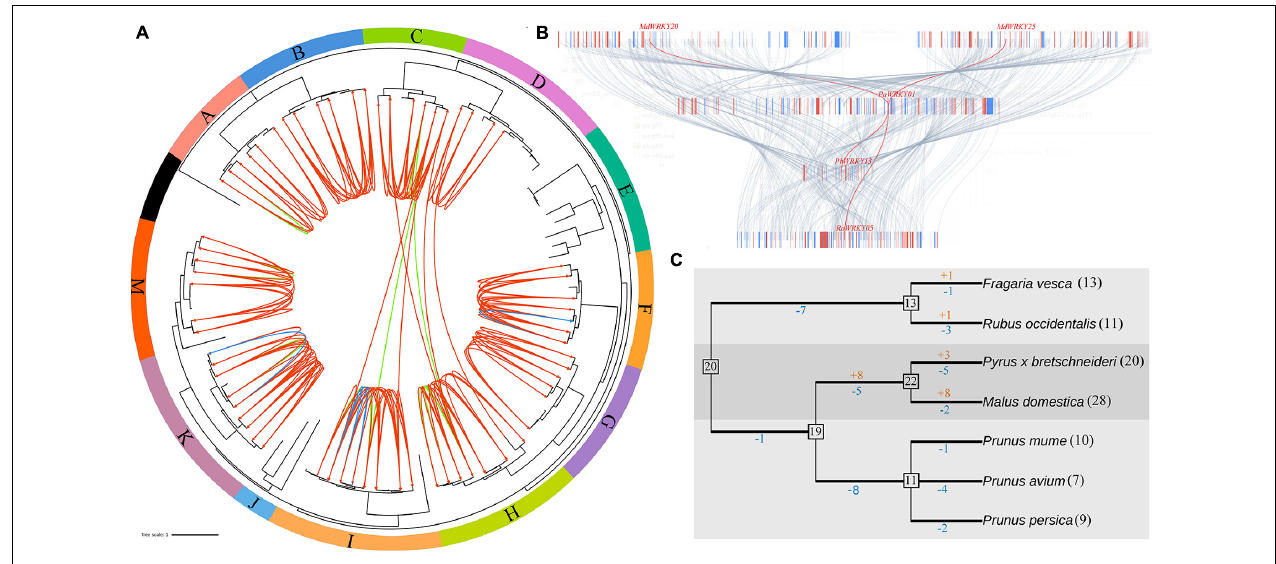
FIGURE 3 | The expansion mechanism analysis of WRKY I genes in seven Rosaceae genomes. (A) Orthologous groups were identified among F. vesca , R. occidentalis , P. persica , P. avium , P. mume , P. bretschneideri , and M. domestica . (B) Microsynteny maps of WRKY I genes across the selected Rosaceae genomes. (C) Estimated gene numbers in ancestral species and gains/losses of genes during WRKY I genes evolution in seven Rosaceae